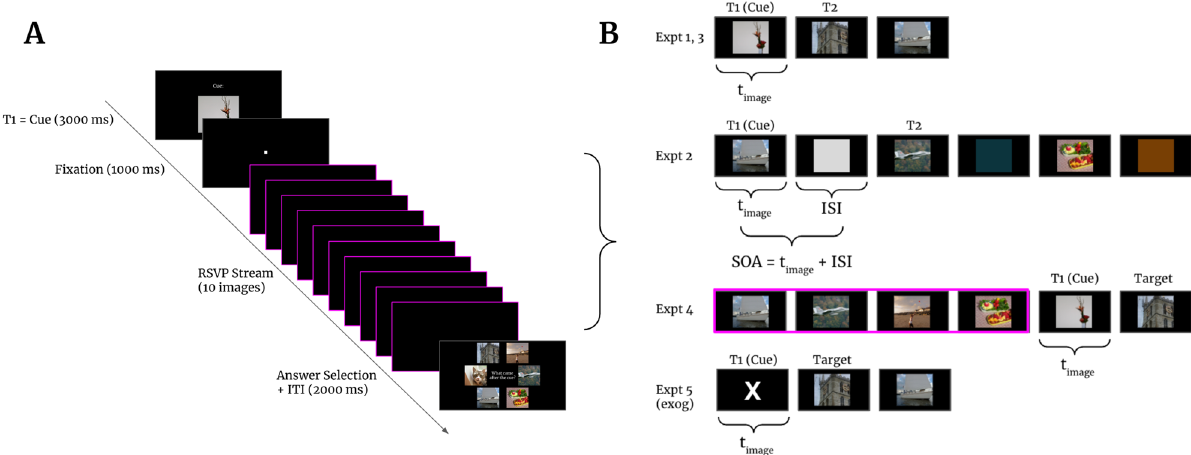
screen, and a 2000 ms ITI. ( B ) Sample of 3 images from the 10-image RSVP stream to illustrate stimulus structure for each experiment. All trials for all experiments always had 10 images. T2 image directly followed the T1 cue image, and T1 and T2 stimuli were always presented within the 10-image RSVP sequence. Experiment 1, Experiment 3, and Experiment 5, SOA = t image and no fillers were present . Experiments 2A-C used fillers and varied SOA and t image according to the specified conditions (see Table 1; SOA = t image + ISI). In Experiment 4, the target was always preceded by the same four images (SOA = t image ). The exogenous T1 cue in experiment 5 was a large white “X”, and the endogenous (top-down) T1 cue was identical to the Experiment 1 and 3